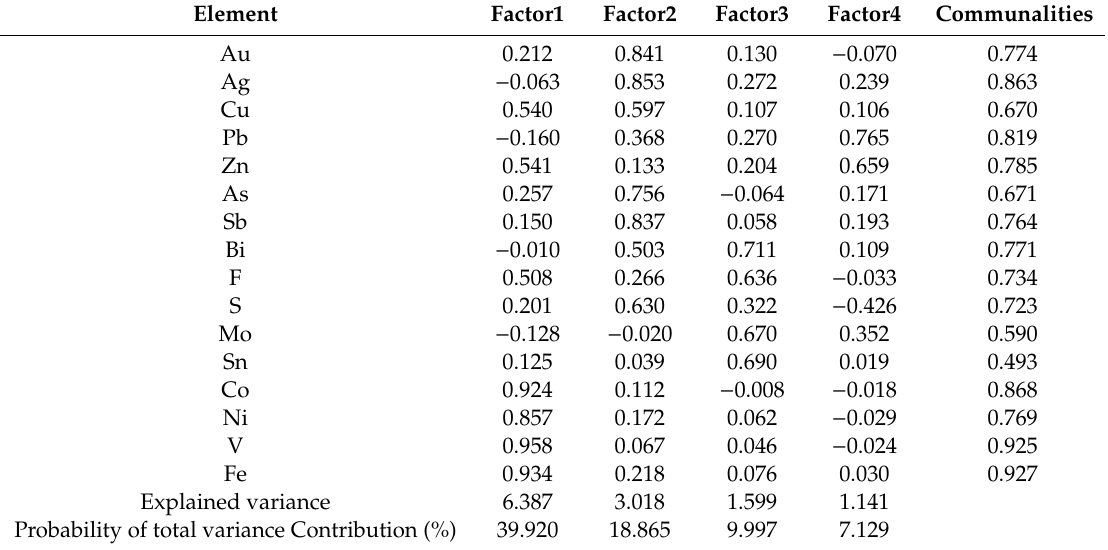
Table 3. Loadings of factor analysis carried out with all 16 analyzed elements (after varimax